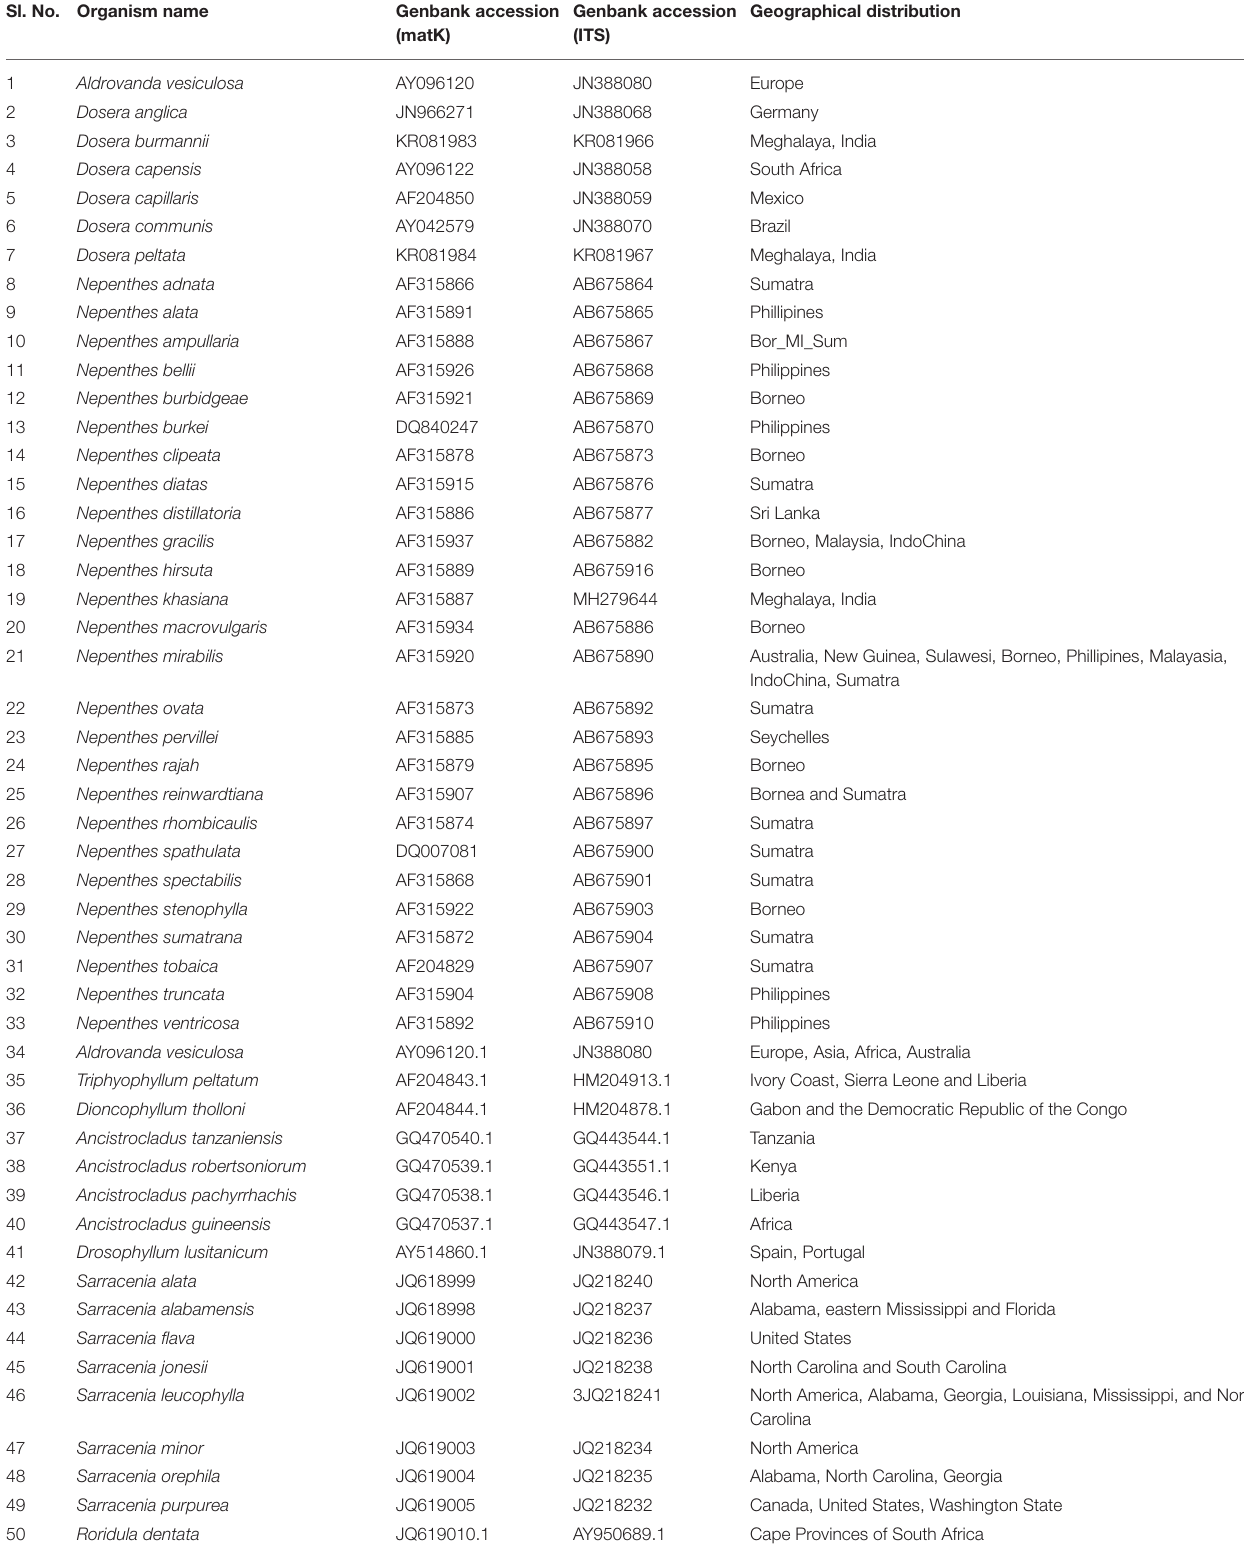
TABLE 3 | List of mat K and ITS GenBank accessions for representative species belonging to Nepenthaceae, Droseraceae, Sarraceniaceae, and Roridulaceae carnivorous plant families used in this study along with geographical distribution. Sl. No. Organism